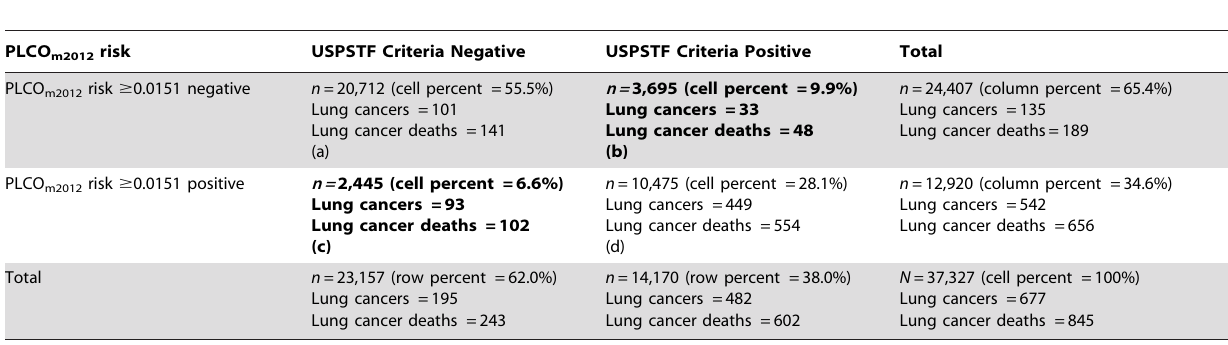
Table 2. Distribution of observations and lung cancer events by USPSTF criteria and PLCO m2012 risk $ 0.0151 criterion status in PLCO intervention arm smokers.